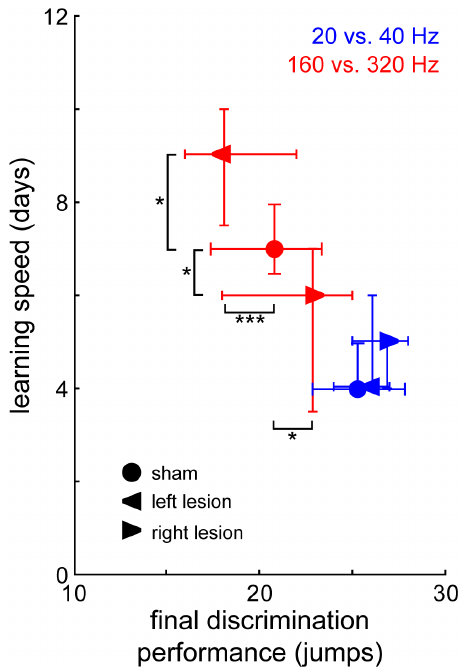
Figure 3. Comparison of two measures of learning perfor- mance, learning speed (LS) and final discrimination perfor- mance (final DP). LS is identified as the first day with significant performance, i.e. with a significant difference of CS + and CS– induced hurdle jumps (fourfold table x 2-test, note that a smaller value reflects faster learning), final DP is a measure of how well the animals finally learn to discriminate the stimuli and is defined as the median of the differences between CR + and CR- across the last 8 training sessions of each individual animal (cf. Methods). Given are median values and quartiles for animals that were trained to discriminate periodicities of 20 Hz vs. 40 Hz (blue data points) or 160 Hz vs. 320 Hz (red data points). Between-group comparisons for LS and final DP were carried out using Bonferroni-corrected Mann-Whitney U-statistics, p-le- vel:.*p , 0.05, ***p , 0.001.